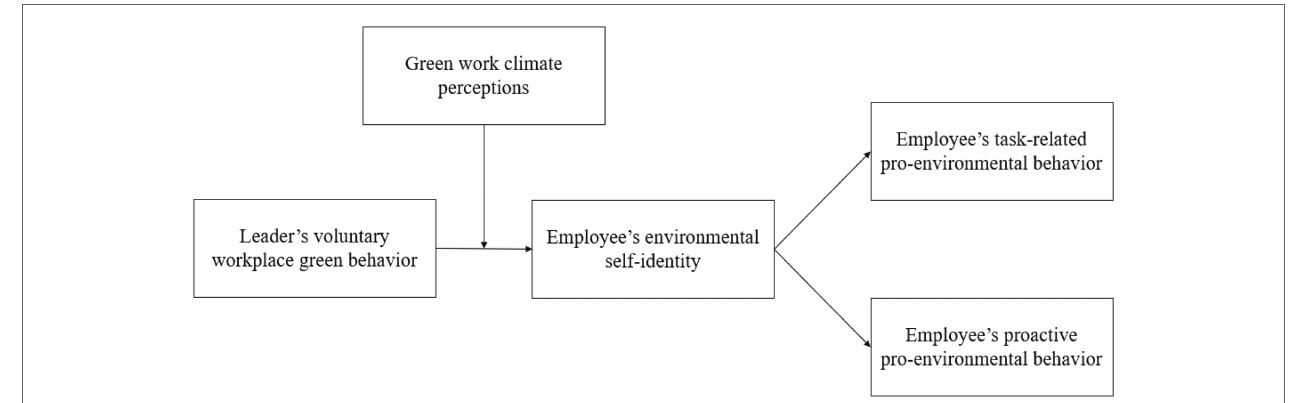
FIGURE 1 | The hypothesized